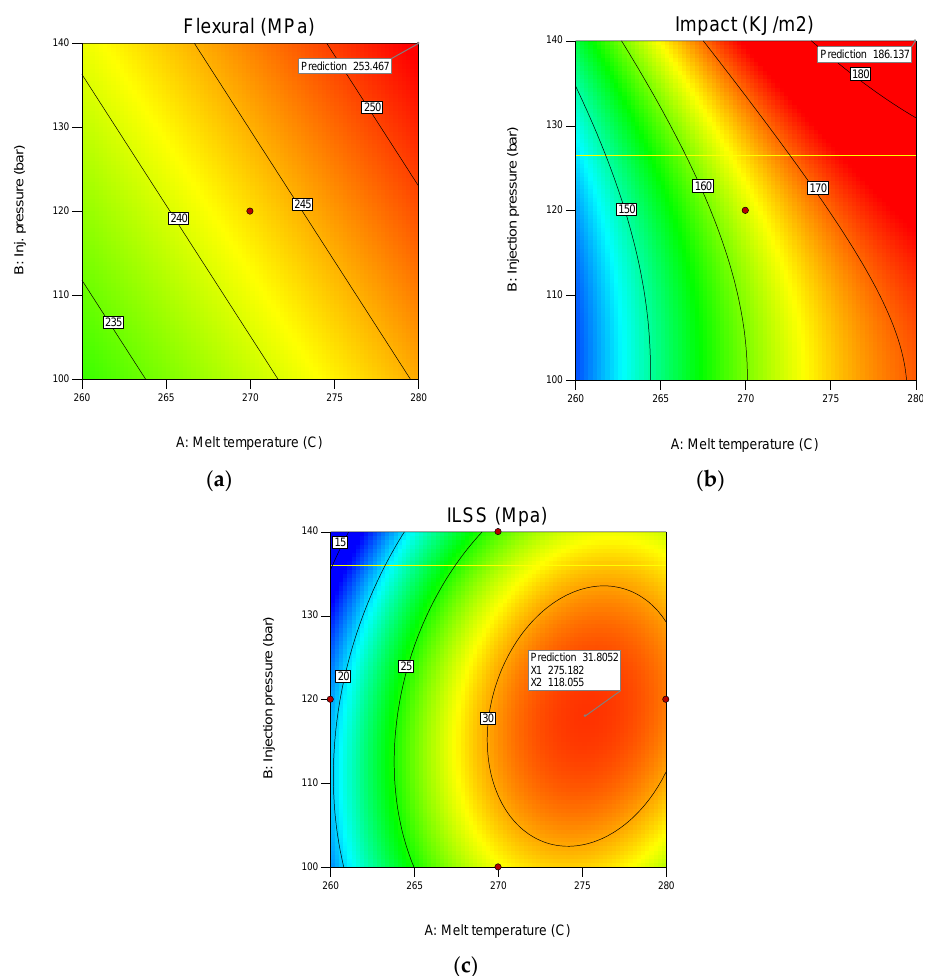
Figure 4. Effect of injection pressure and melt temperature on the target responses: ( a ) flexural strength; ( b ) impact strength; ( c ) ILSS.